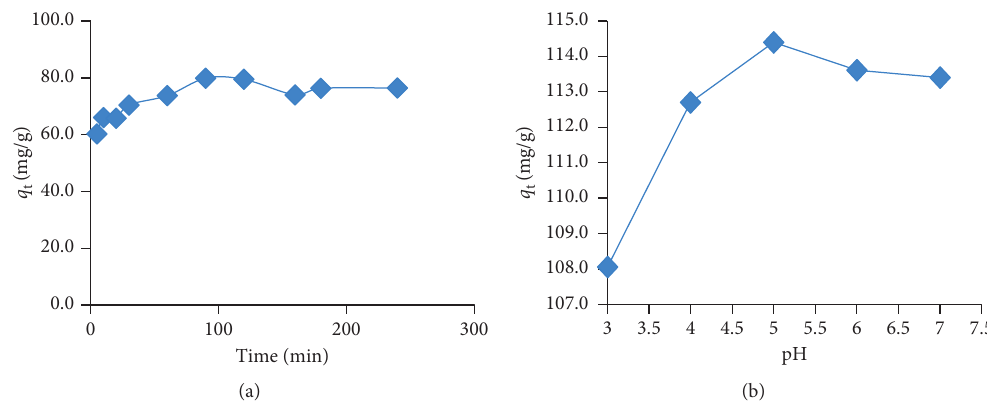
Figure 3: Adsorption trend for Cd (II) on G-3 PAMAM SGA as time (a) and pH (b) increased.